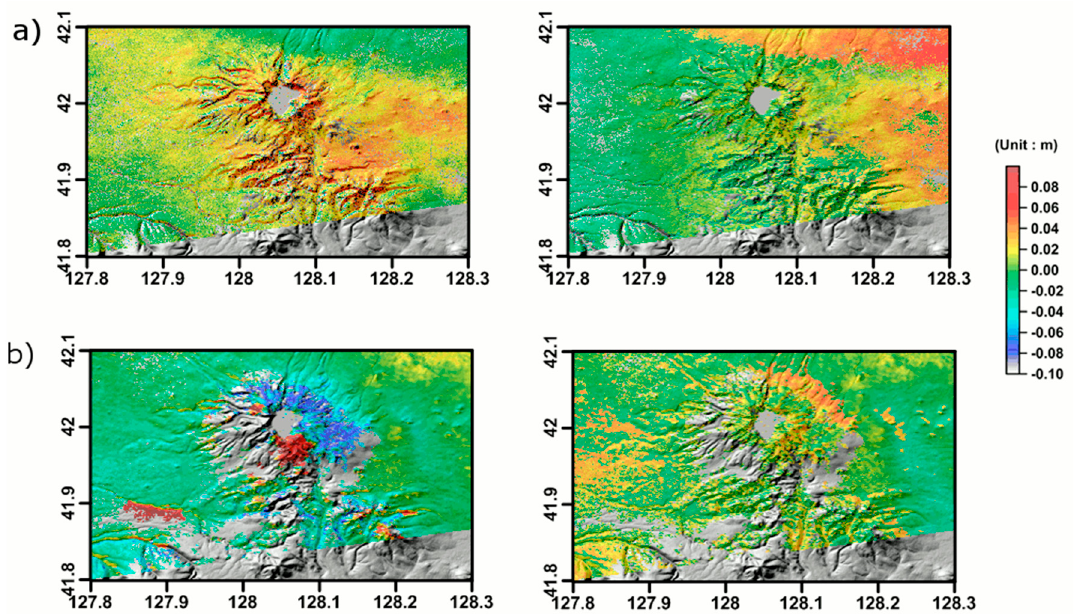
Figure 5. The two-pass D-InSAR processing using ALOS PALSAR pair (left: before atmospheric error correction, right after error correction) ( a ) the pair 1DInSAR results obtained on 2009/07/19 and 2009/09/03, ( b ) the pair 2 results obtained on 2010/01/19 and 2010/04/21.